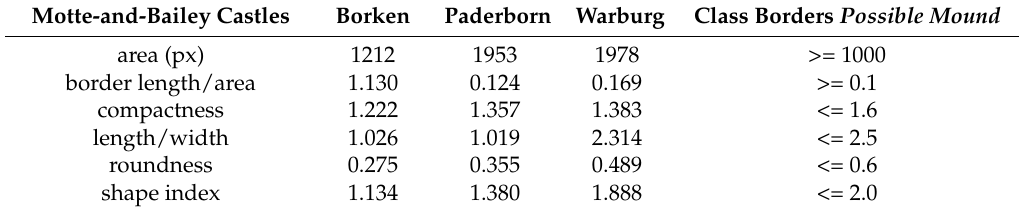
Table 2. Overview of the objects representing the real-life mottes and the derived class borders. Motte-and-Bailey